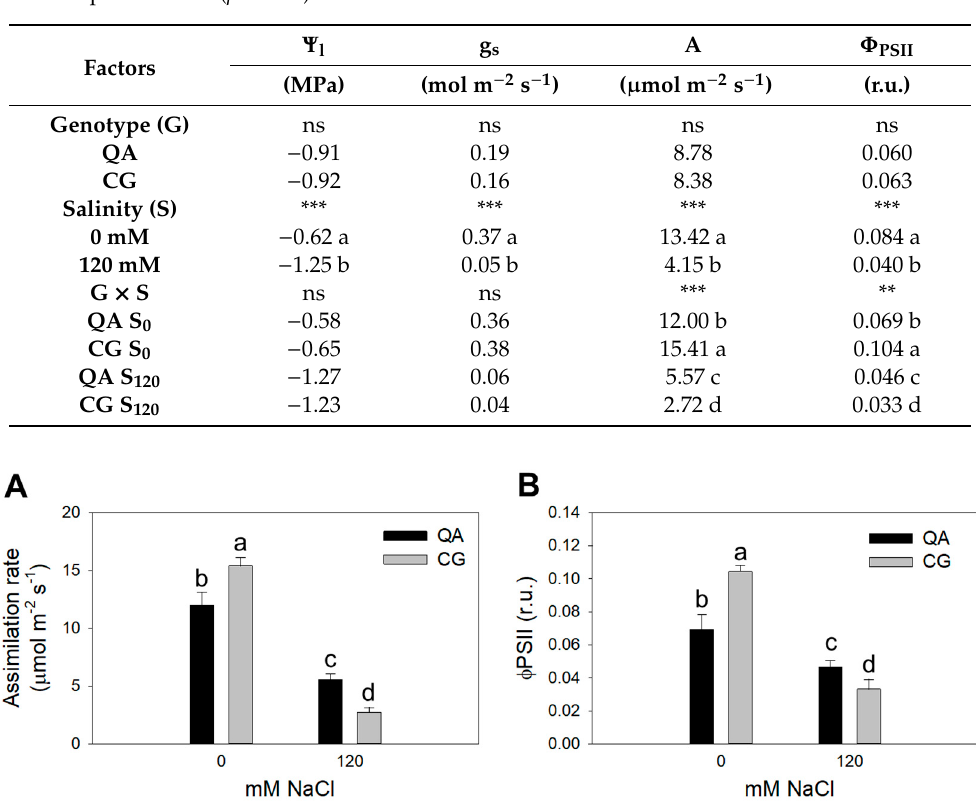
Figure 2. ( A ) Net photosynthetic CO 2 assimilation ( A , µmol m 2 s − 1 ), and ( B ) quantum yield of PSII ( Φ PSII , relative units, r.u.) under 0 mM (control) and 120 mM (high salinity) in the commercial cultivar QA (black bars) and in the landrace CG (gray bars) at DAT 102. Means with the same letter are not significantly different according to Duncan’s test.